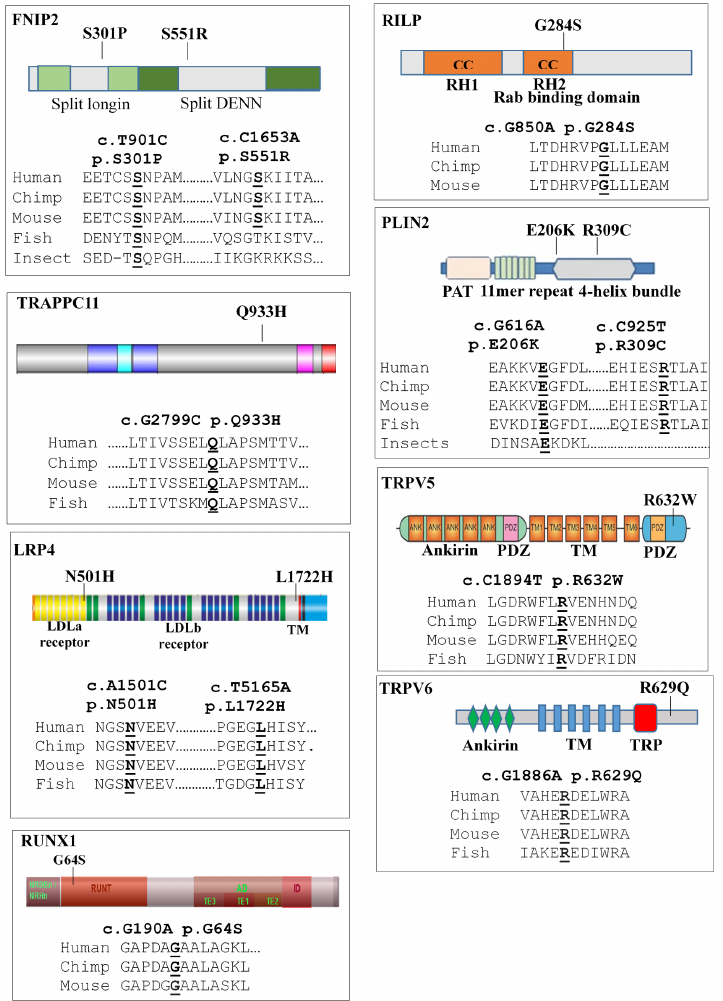
Figure 4. Evolutionary conservation study of the rare deleterious variants identified in the modi- fier genes. The affected residues are reported in bold underlined. For each gene, we reported the protein structure and the localization of the identified variant on protein domain.